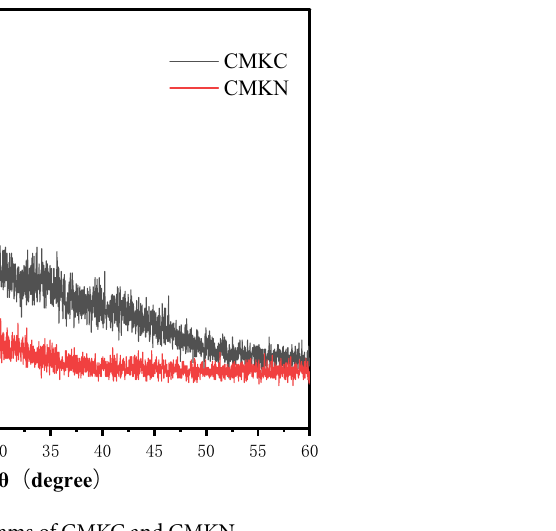
Figure 6. X-ray diffractograms of CMKC and